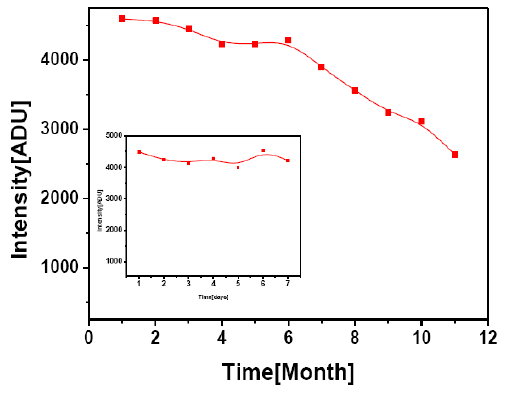
Figure 8 . Inter-day stability of AlOx in bi-enzyme reaction in 96 well plate formats activity over the period of 11 months. Inset: activity over the period of one week. 0.5 mM methanol with 0.001U HRP and 1mM luminol were used throughout the assay